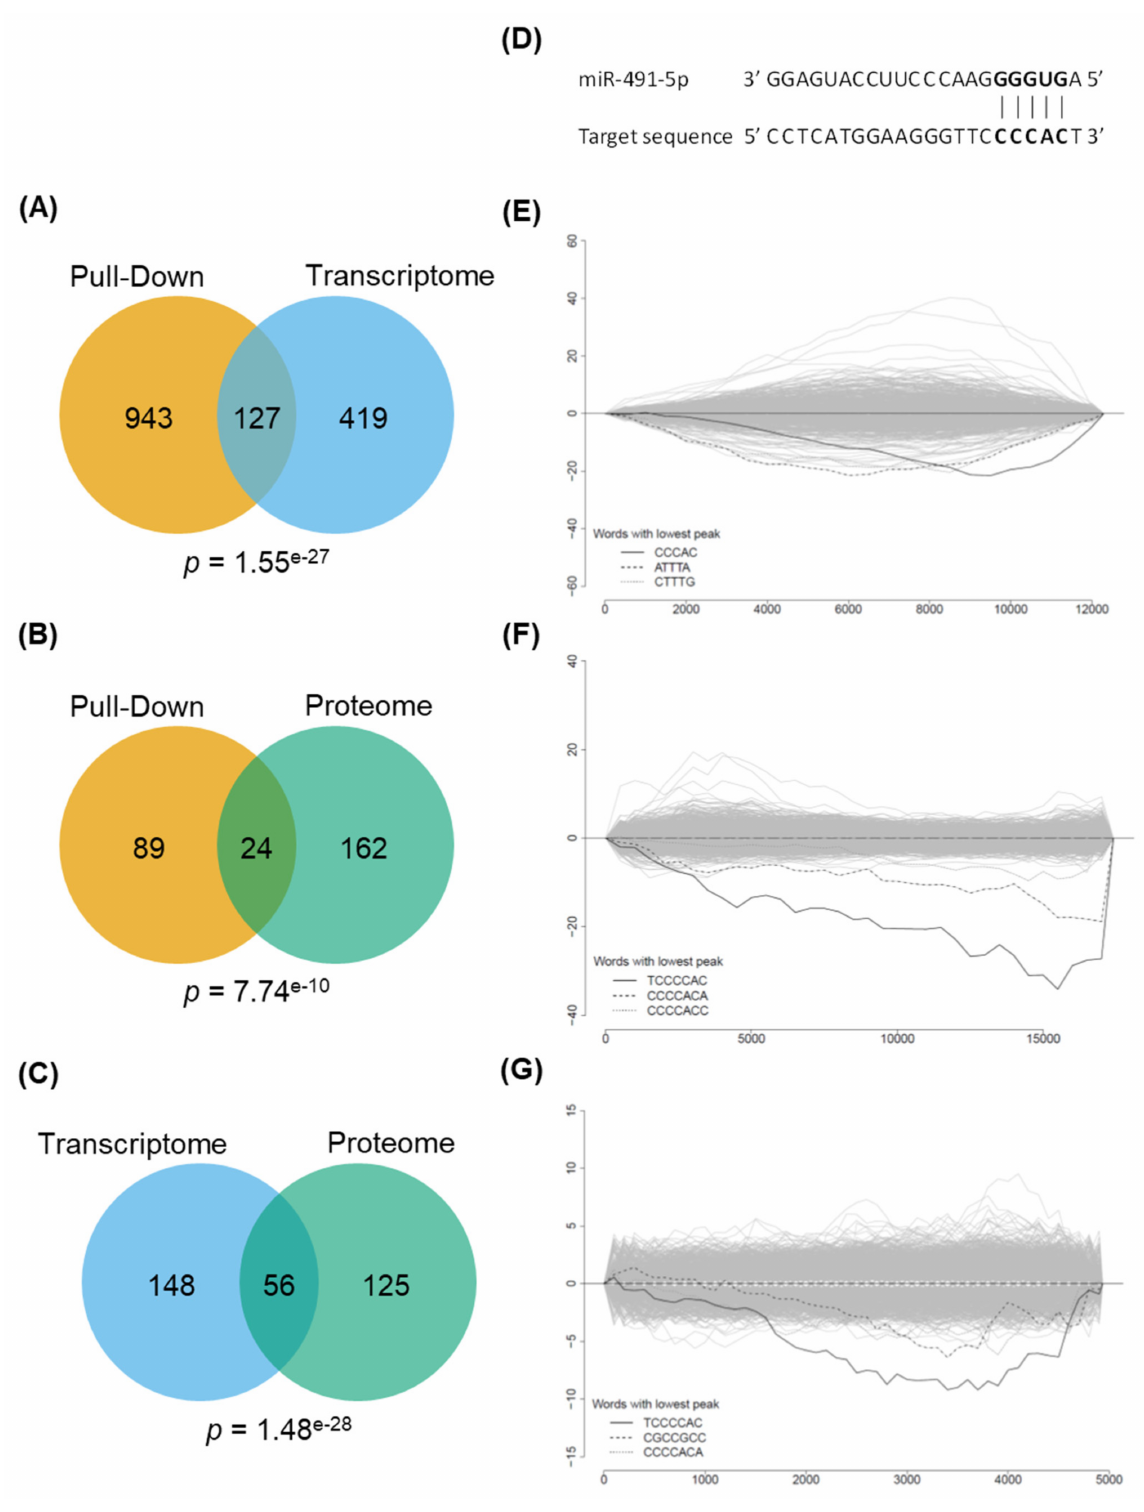
Figure 2. Pull-down of direct targets, transcriptome and proteome experiments identifying miR-491-5p specific effects. ( A – C ) are lists of differentially expressed/enriched gene were overlapped. The significance of the overlap was calcu- lated with a hypergeometric test. ( D ) MiR-491-5p and complementary sequences are shown; the seed region is in bold. ( E – G ) Pulled-down RNAs ( E ) were ranked from lower to higher enrichment ratios; transcripts ( F ) and proteins ( G ) were ranked from up- to down-regulated. Distribution of words of 5 (pulled-down RNAs) and 7 (transcripts and proteins) letters were analyzed in the 3 (cid:48) UTR sequences of the matching transcripts. The top 3 most significantly enriched words are